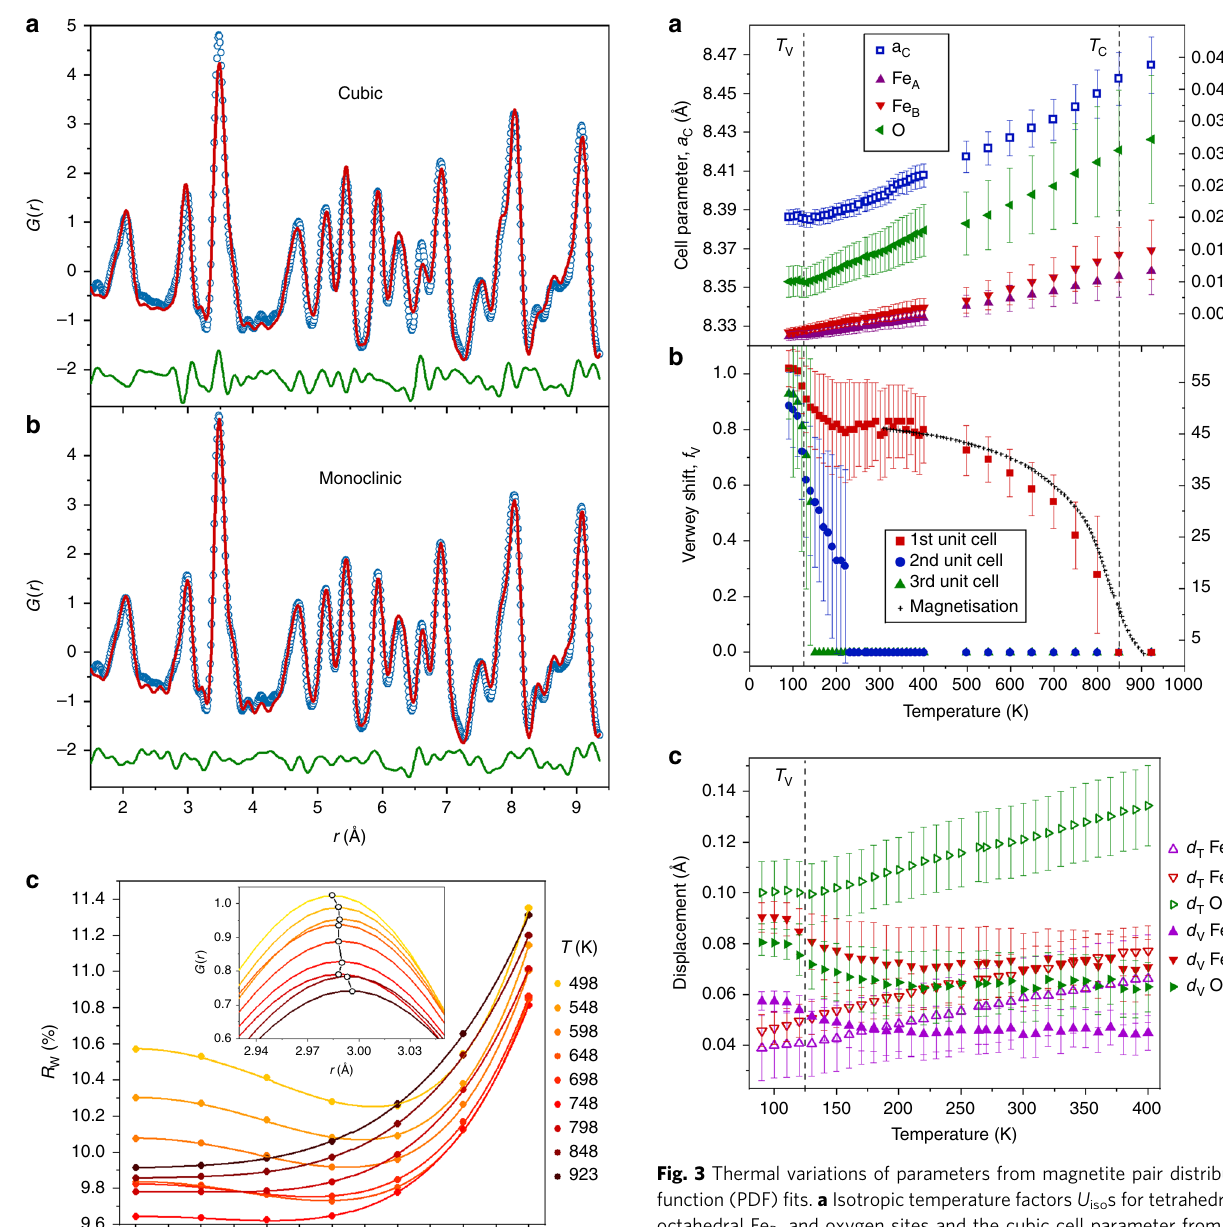
directly measured, their lack of correlation with phonon motions